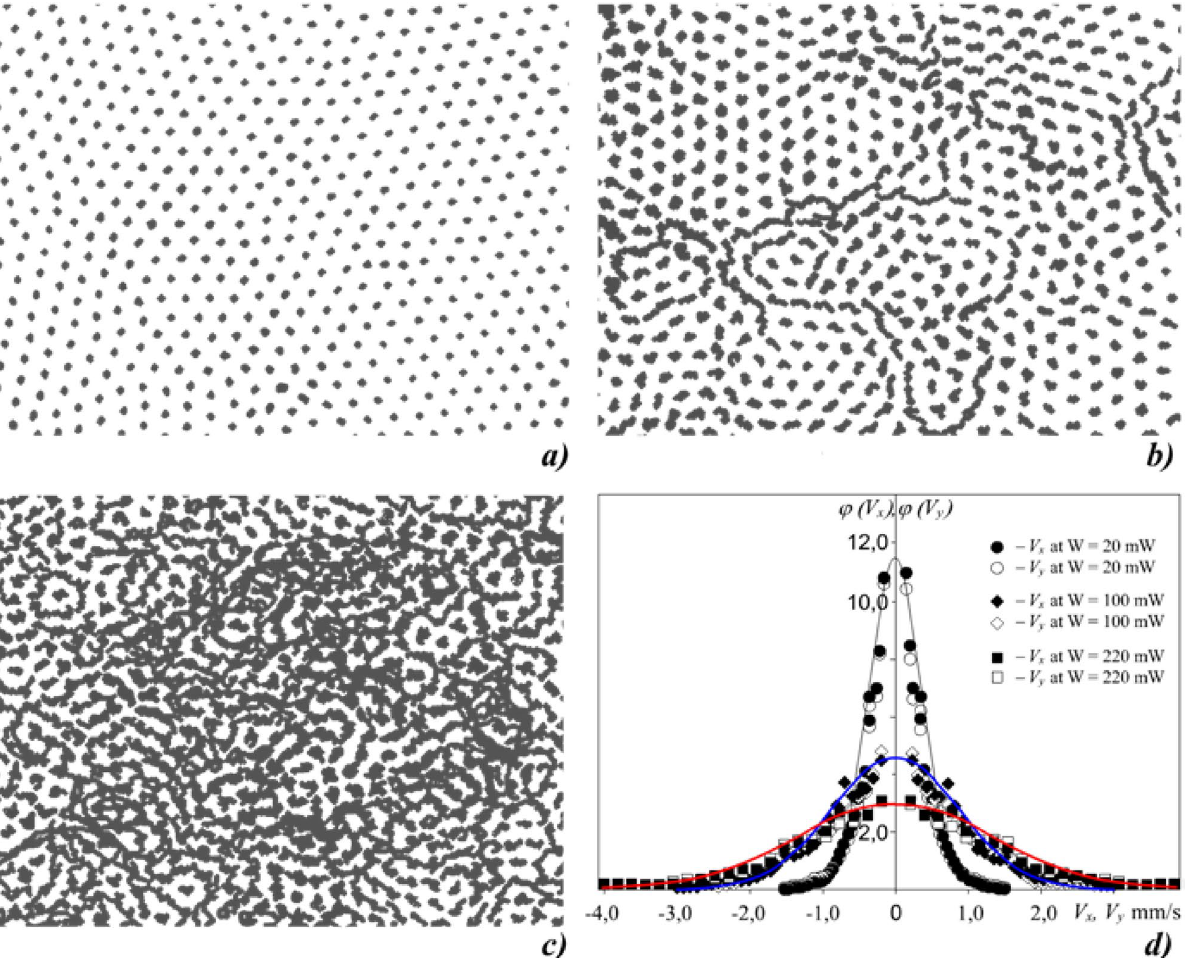
Figure 2. Illustration of typical 1 s particle trajectories in dust monolayer in RF discharge under laser irradiation of power W : ( a ) 20 mW, ( b ) 100 mW, ( c ) 220 mW. ( d ) Velocity distribution profiles (symbols) with Maxwell approximation (solid lines): black is for Γ * ~ 600 (W = 20 mW), blue is for Γ * ~ 140 (W = 100 mW) and red is for Γ * ~ 50 (W = 220